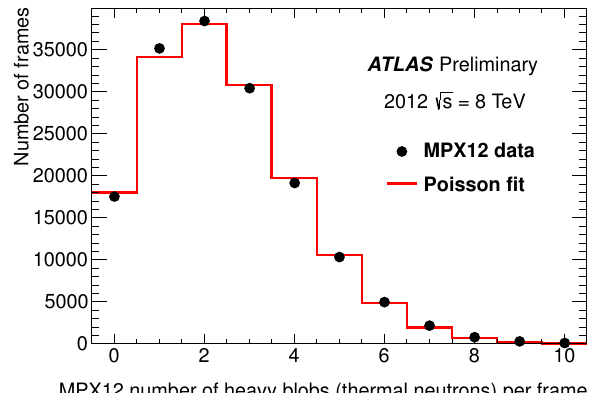
Figure 24. Distribution of the number of heavy blobs per frame, recorded with MPX12 below a 6 LiF converter, during LHC collision periods in 2012. The line shows a histogram with a fitted Poisson distribution. Taken from Ref. [12].